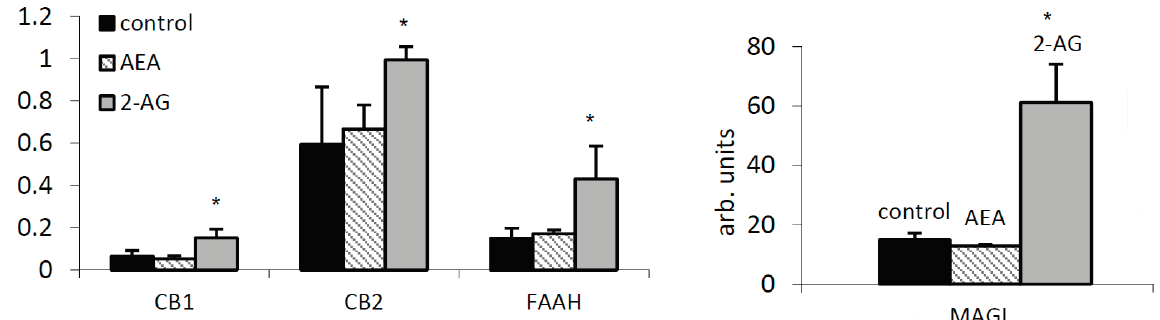
Figure 3. Internal regulation of the EC system by arachidonoyl ethanolamide (AEA) and 2-arachidonoyl glycerol (2-AG). Cannabinoid receptors CB1, CB2, FAAH and MAGL mRNA expression in peripheral blood mononuclear cells (PBMC) by AEA (2.5 µM) and 2-AG (20 µM) was measured by TaqMan PCR and normalized to 18S RNA. * p < 0.05 vs. untreated